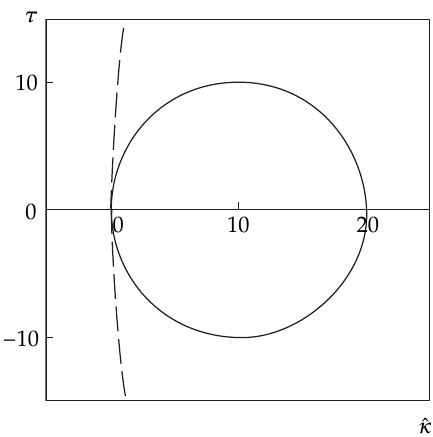
Figure 7.1 . The torsion τ in relation to curvature parameter ˆ κ plot- ted by ( 7.2 ) with a = const. Solid line: a = 0 . 1; dashed line: a = 0 . 01. Its parameter l/ ˆ κ from ( 7.3 ) can be used as a measure of the distur- bance’s delocalization. So, the more the line is curved, the more the in- clusion of the redundant segment ( 7.6 ) is